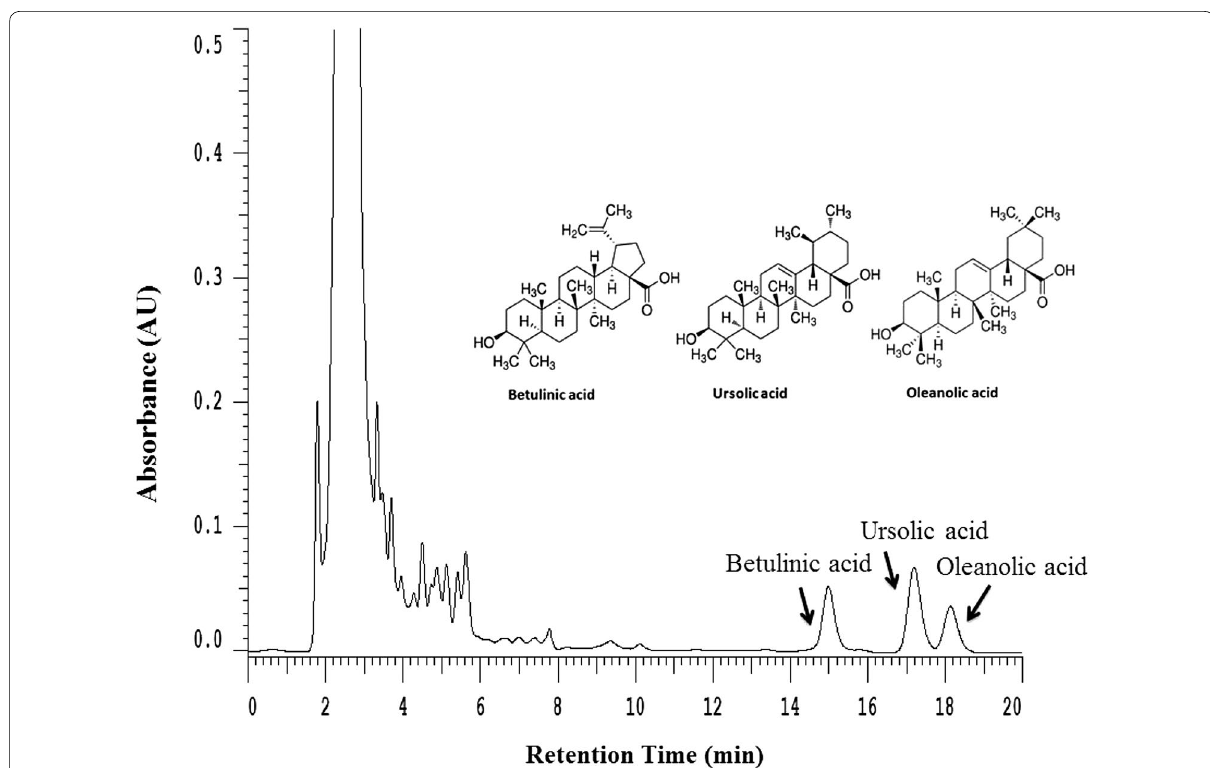
Fig. 1 HPLC chromatograms (280 nm) of ethyl‑acetate fraction of the stem of A. callosa var. callosa